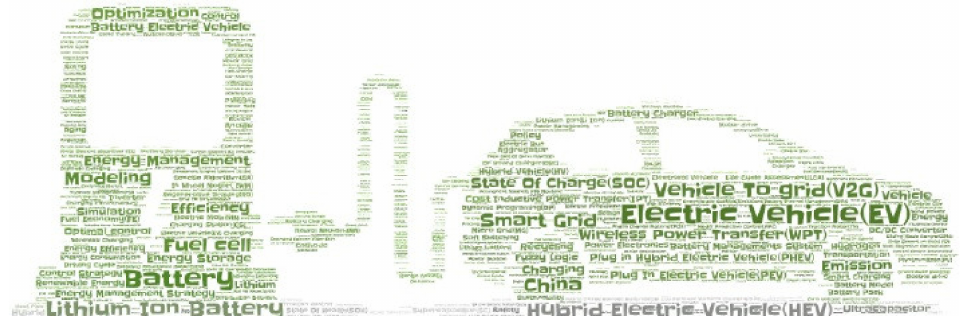
Figure 4. Representation of the global keywords of all communities.